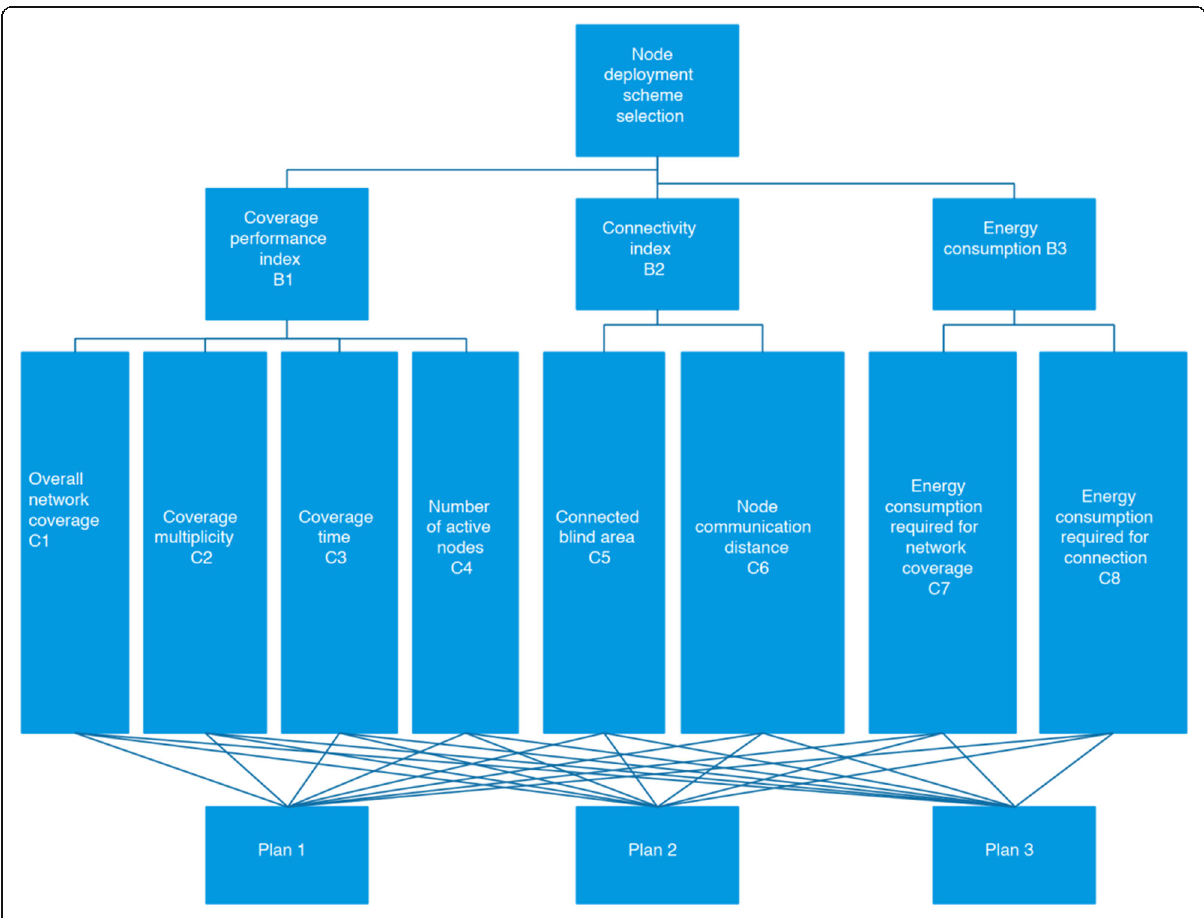
Fig. 11 Hierarchical model of node deployment scheme